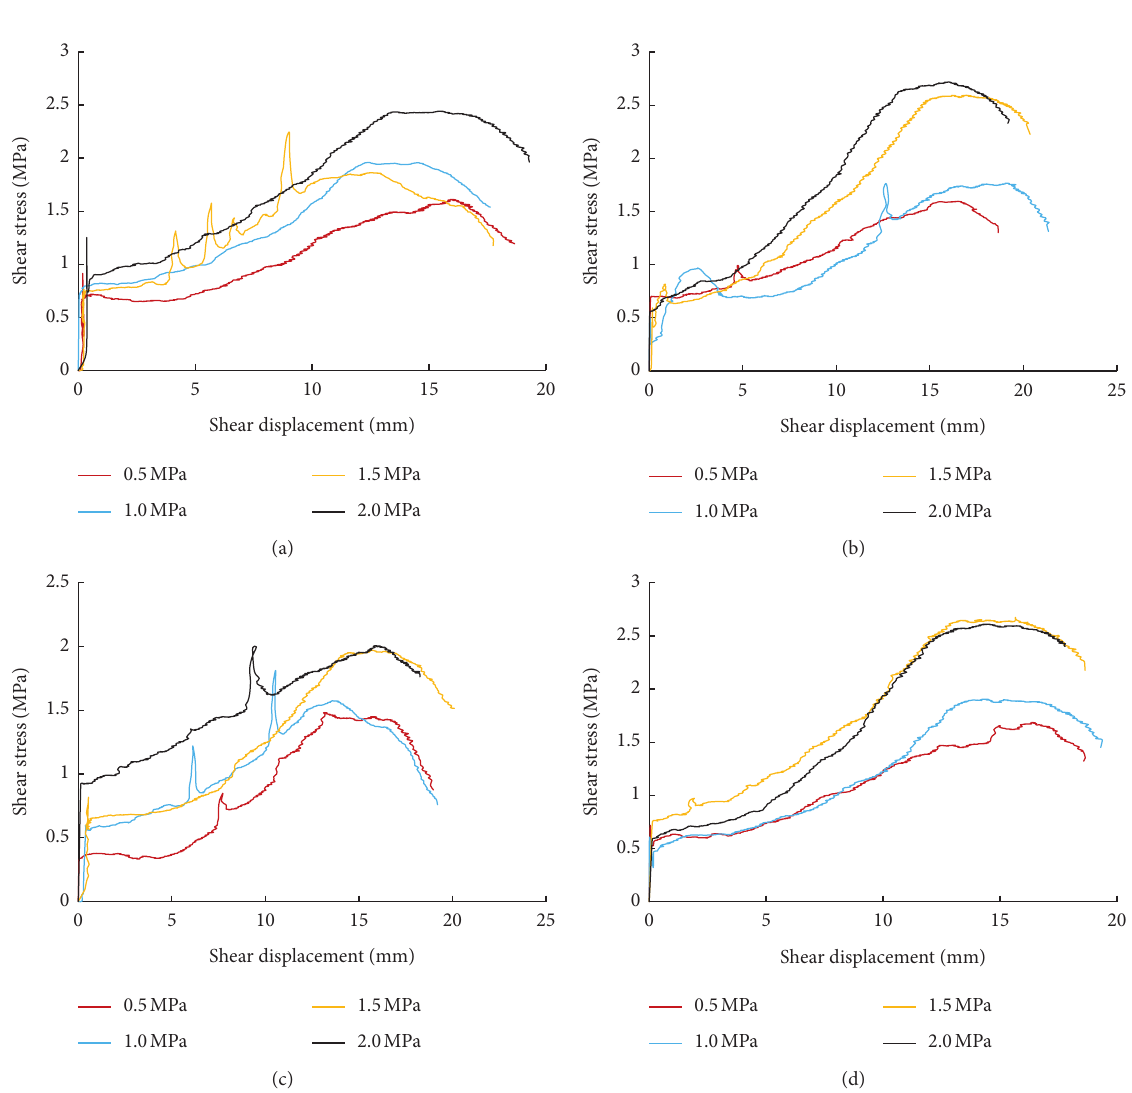
Figure 8: Shear stress-shear displacement curves of different normal stress joints with 10mm opening degree. (a) Specimen 1#. (b) Specimen 2#. (c) Specimen 3#. (d) Specimen